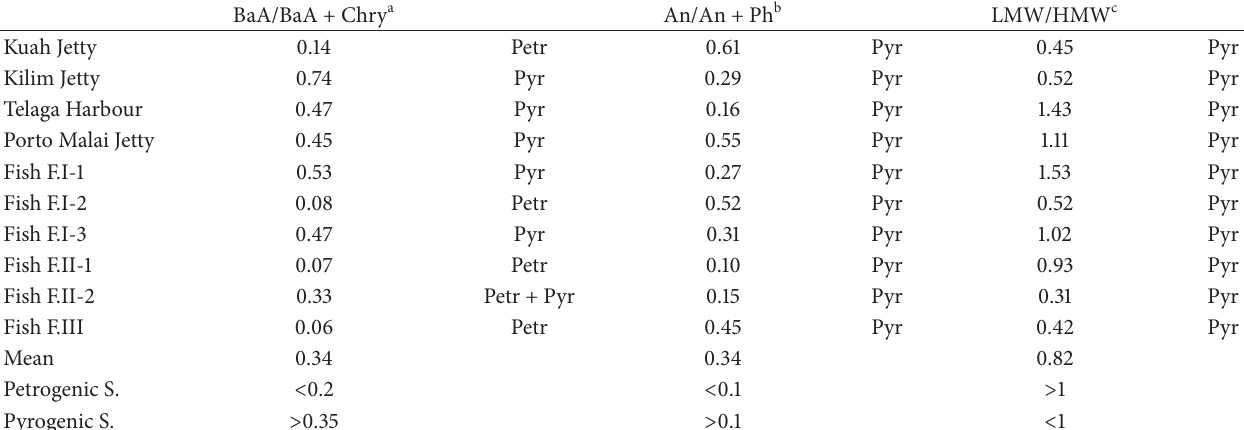
Table 6: Diagnostic PAH ratios in the sediment and their possible sources.